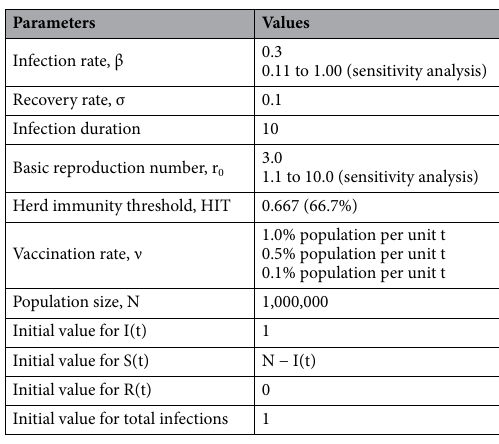
Table 2. Parameter values used in simulations and sensitivity